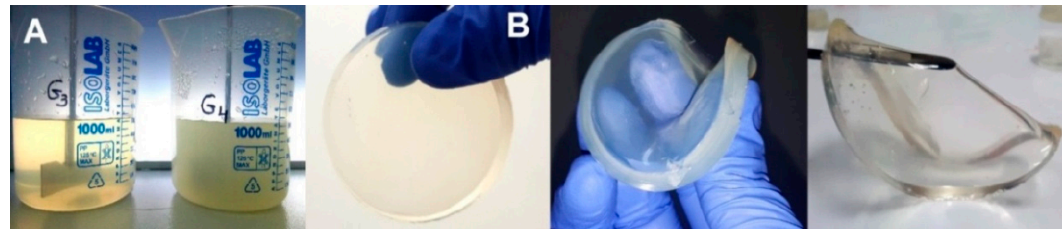
Figure 13. ( a ) Pre-hydrogel solutions before e-beam cross-linking; ( b ) digital photographs of the cross-linked